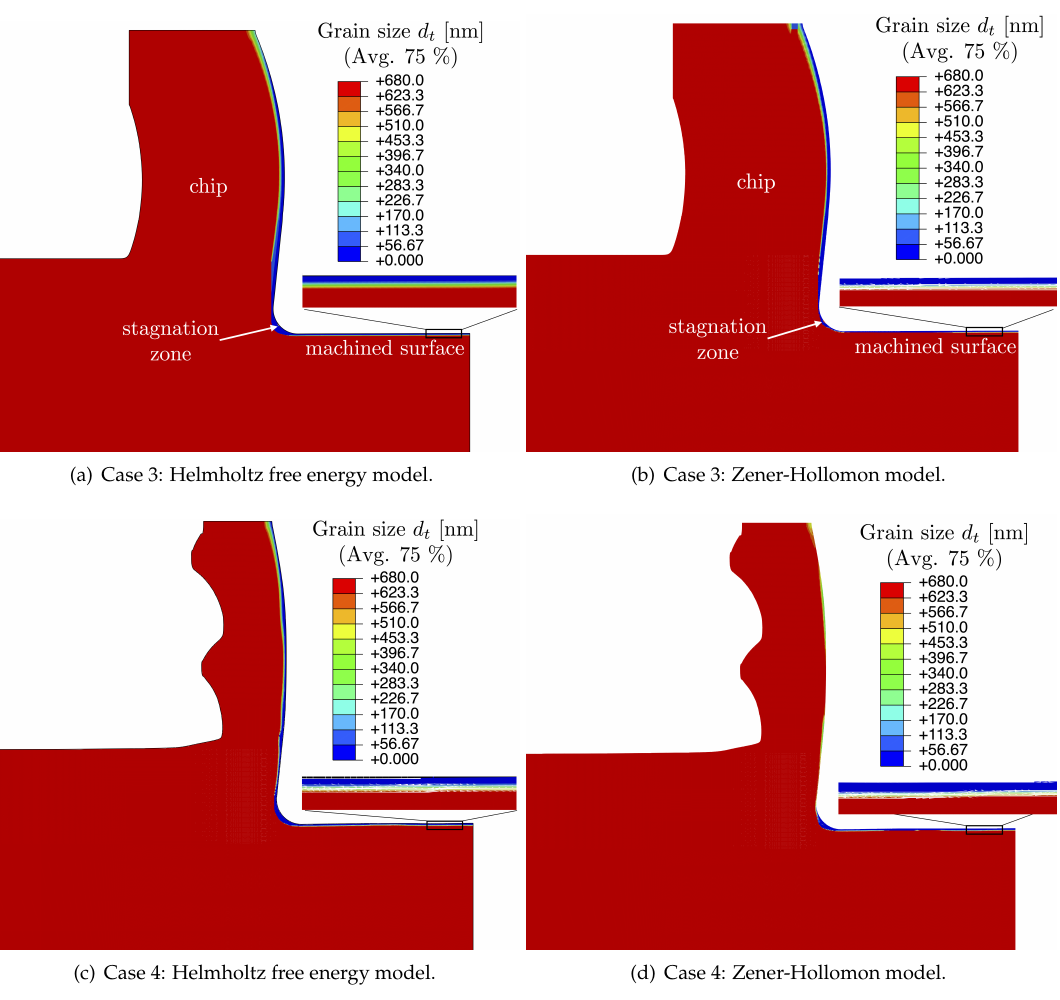
Figure 5. Prediction of grain size d t via Helmholtz energy and Zener-Hollomon models at investigated cases 3 and